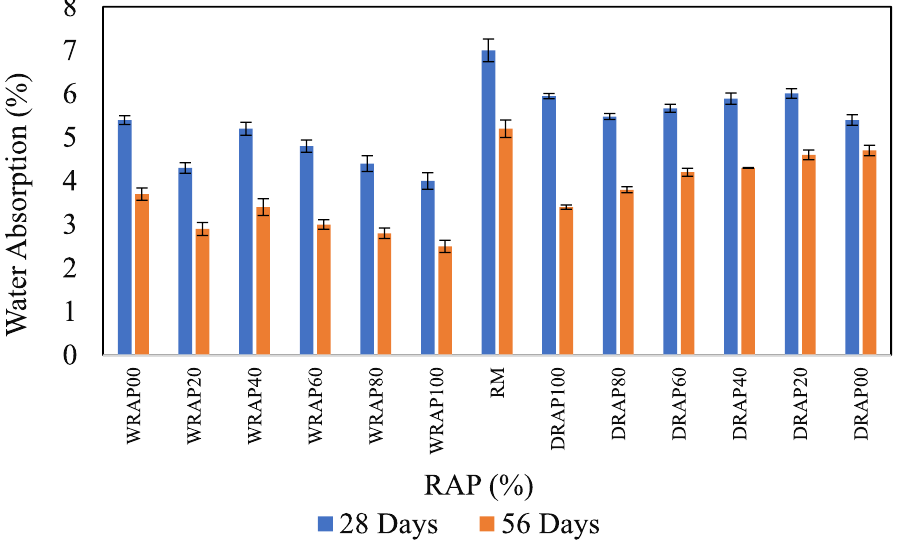
Figure 8. Water absorption characteristics of RAP concrete.